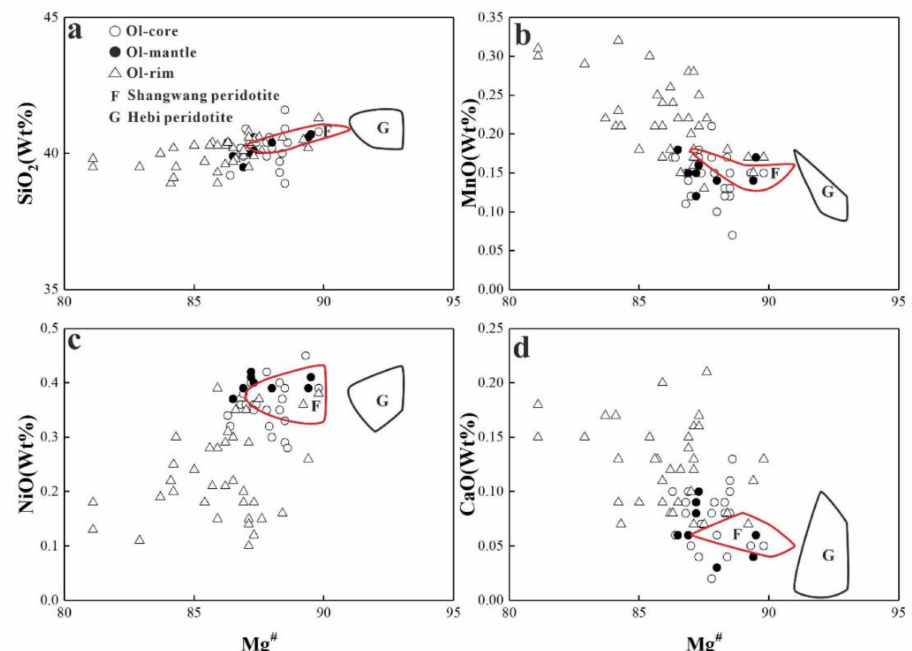
Figure 11. Plots of Mg # vs. SiO 2 ( a ), MnO ( b ), NiO ( c ), and CaO ( d ) for the olivine (Ol). Note: The data of Shanwang and Hebi peridotite are the same as Figure 7.